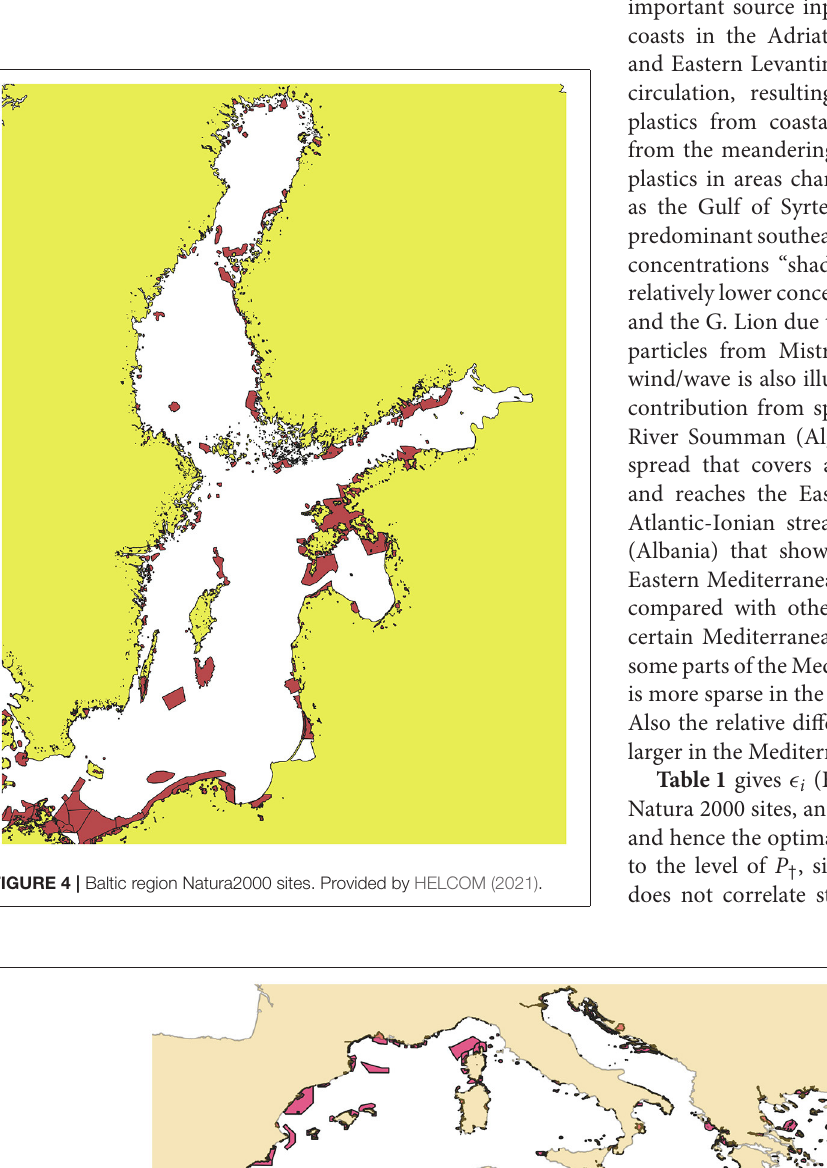
Frontiers in Marine Science |